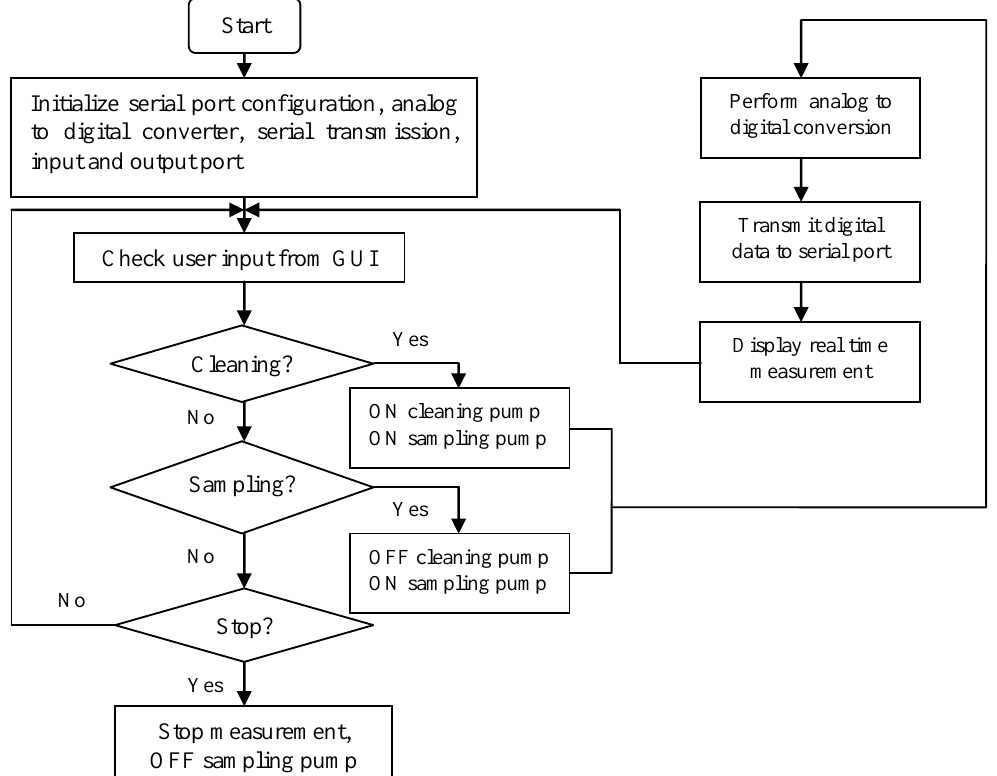
Figure 6. The flowchart of the program embedded into the PIC16F877a